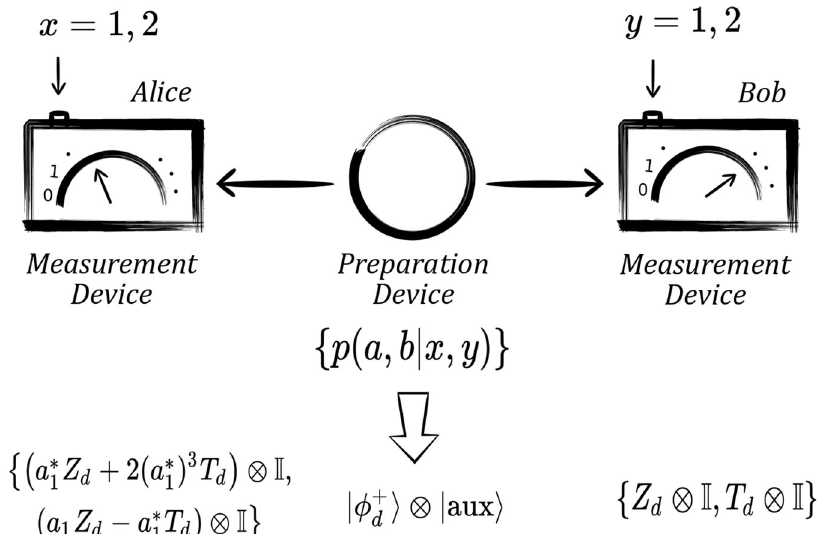
Fig. 1 The self – testing scenario. Alice and Bob receive an unknown quantum system from the preparation device. They have two input buttons, each denoted by 1, 2 specifying two different measurements that they choose at random. The measurements point at one, out of the d outcomes denoted by {0, 1, … , d − 1}. Alice and Bob repeat the experiment to collect statistics. They compare their statistics and fi nd the joint probability distribution for different outcomes and measurements denoted by p ( a , b ∣ x , y ). From the statistics, we self – test the maximally entangled state (1) and two pairs of d -outcome measurements (10,